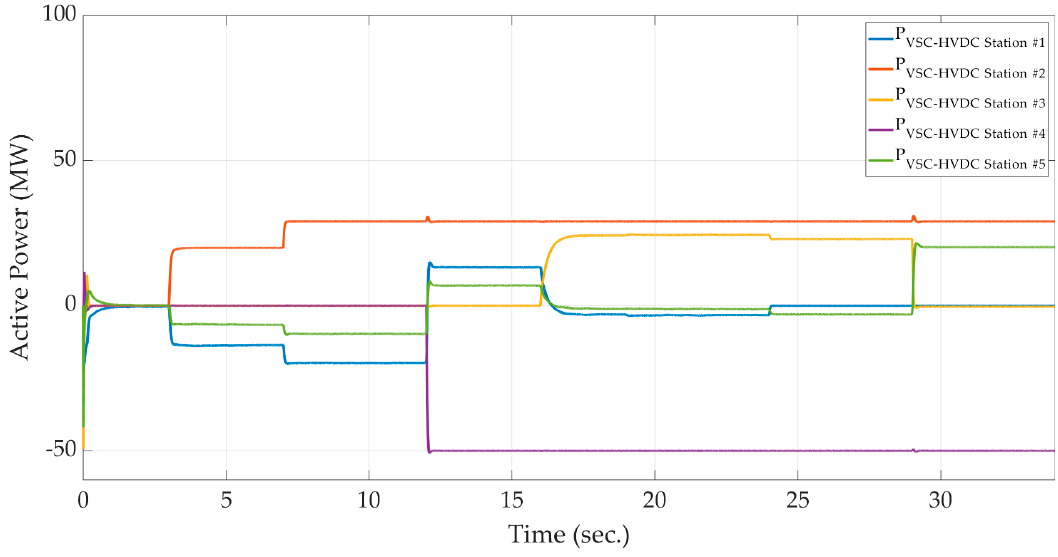
Figure 19. The active power profile of different VSC-HVDC stations in the third scenario.